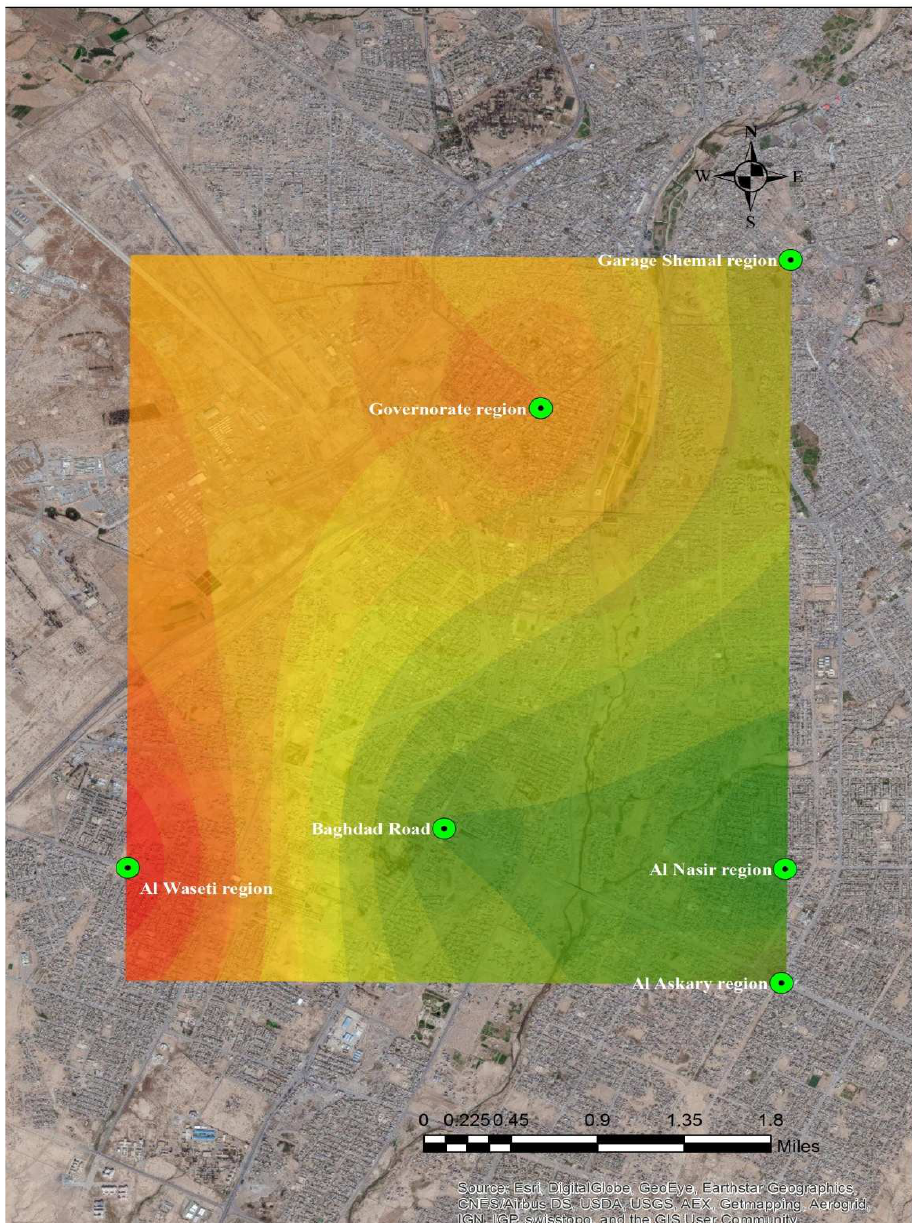
Fig. 4. Daily Noise Distribution for the peak morning and evening traffic flow 4 Jan. 2015 Kirkuk